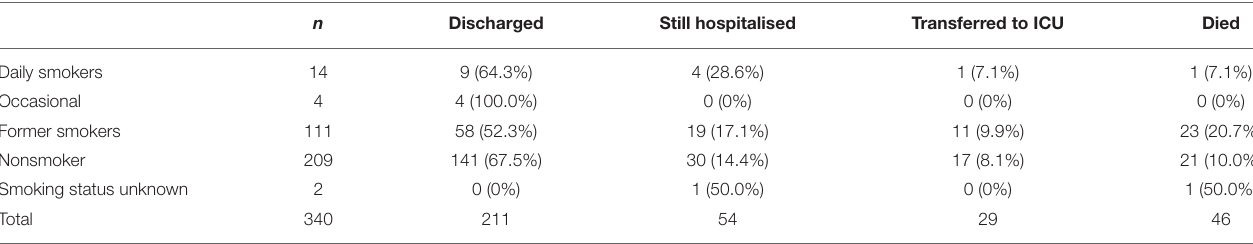
TABLE 3 | Outcomes of